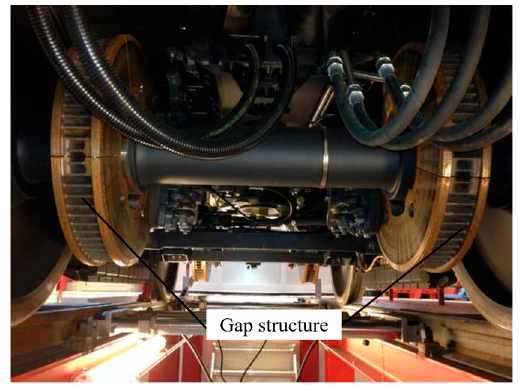
Figure 1. Ventilated brake discs for high-speed trains.